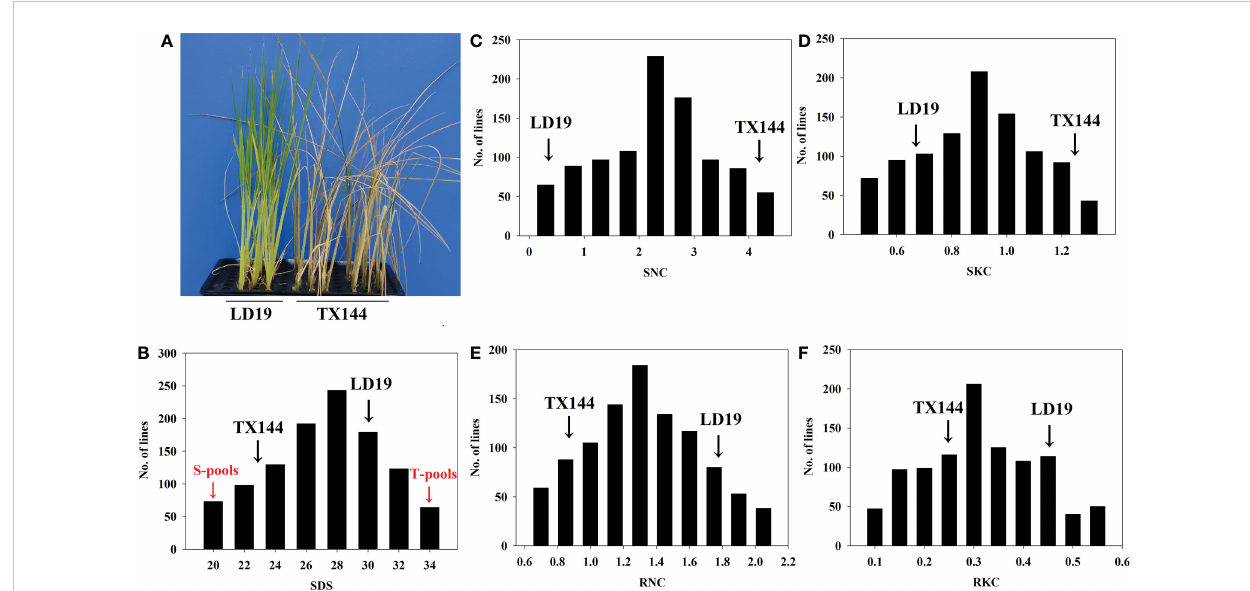
FIGURE 1 Phenotypic analysis of the parents and their derived populations under salt stress. (A) Comparison of the growth of seedling plants of the two parents under salt stress. (B – F) Frequency distribution of days of seedling survival and four physiological traits of shoots and roots of 1002 F 2:3 lines under salt